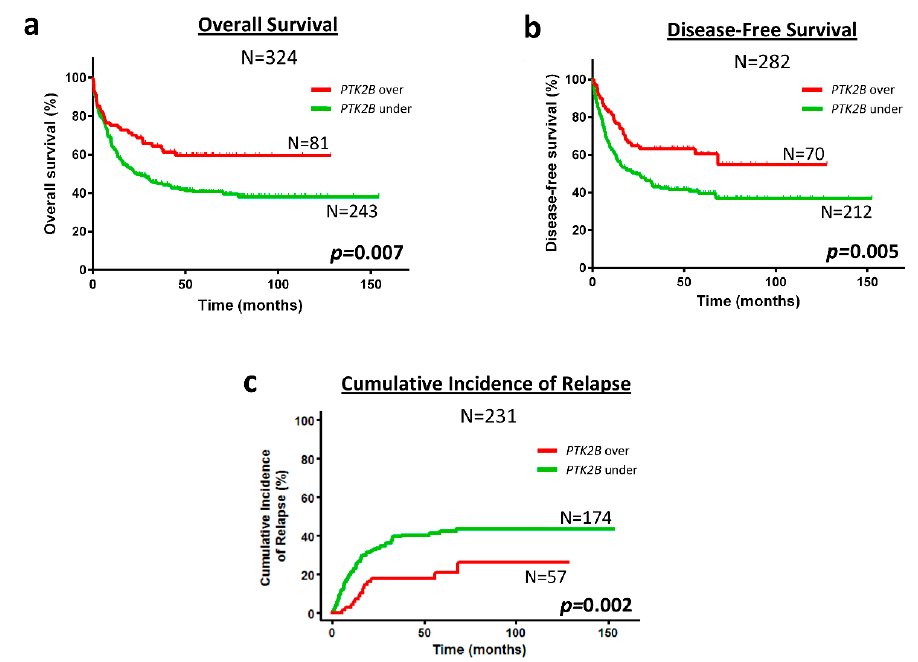
Figure 2. PTK2B overexpression associates with favorable prognosis regarding OS, DFS and CIR in cytogenetic IR-AML patients. Kaplan-Meier curves represent OS ( a ) DFS ( b ) and CIR ( c ), depending on the PTK2B expression. Black line and gray line indicate PTK2B overexpressed and underexpressed, respectively. Log-rank test for OS and DFS, and Gray test for CIR were used to analyze the statistical significance. p < 0.05 was considered statistically significant (bold values). Over; overexpression. Under; underexpression.